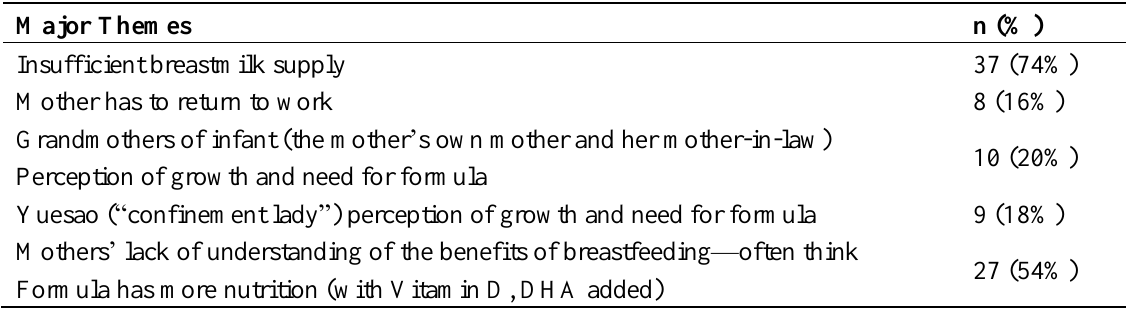
Table 1. Reasons for formula feeding: major themes identified by mothers (n = 50).